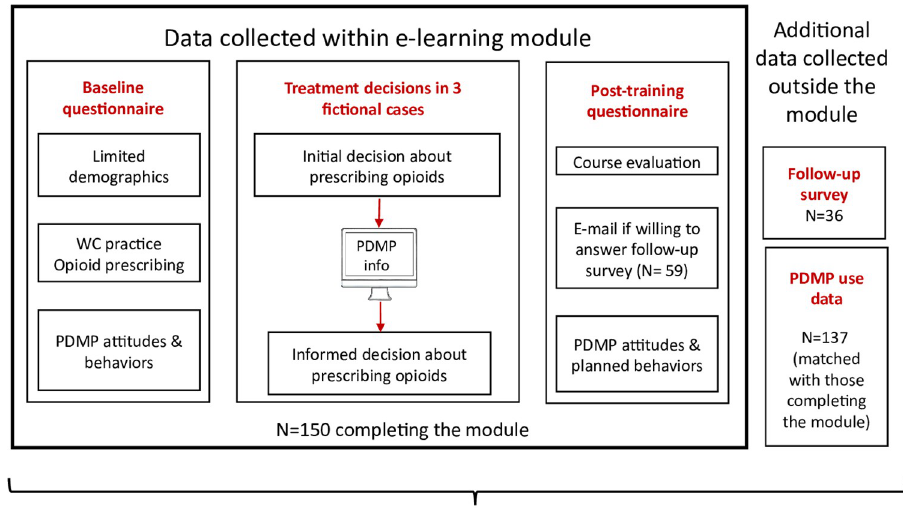
Fig 2. Data sources within and external to